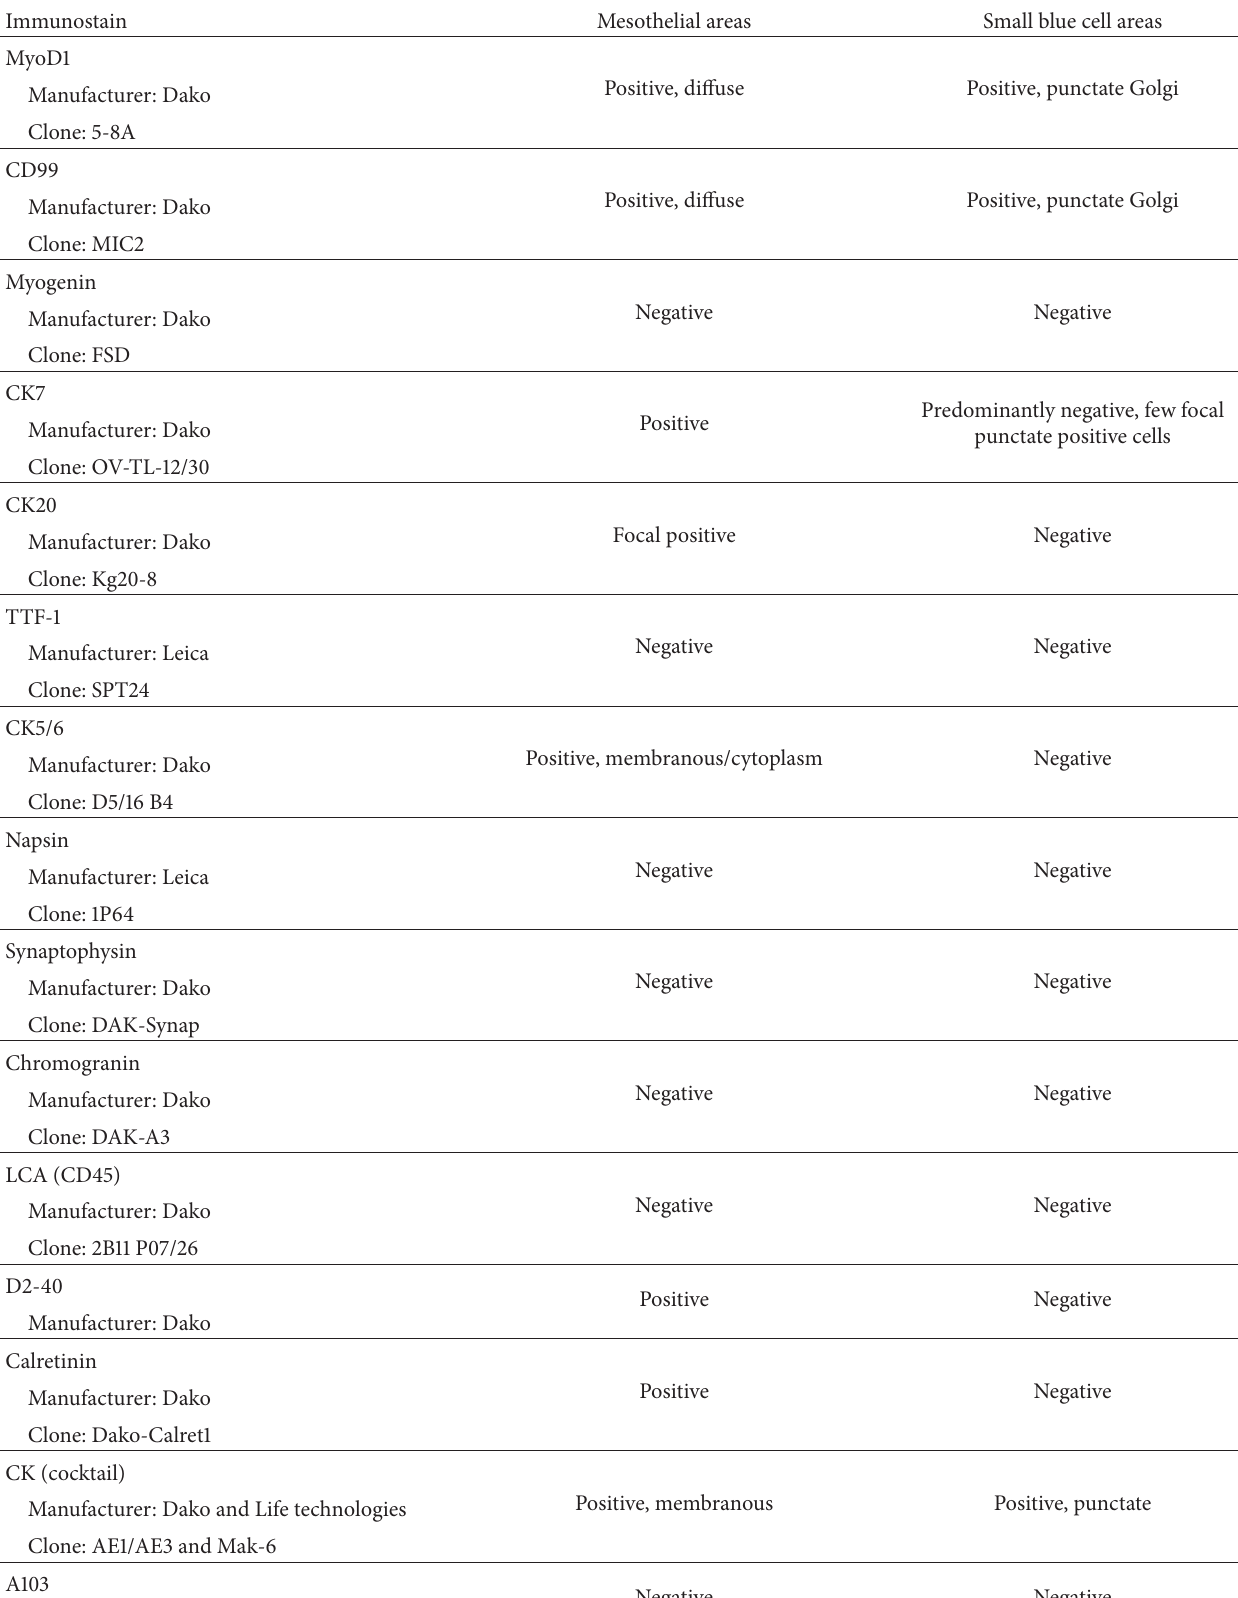
Table 1: Immunostaining results for large and small cell components of biphasic